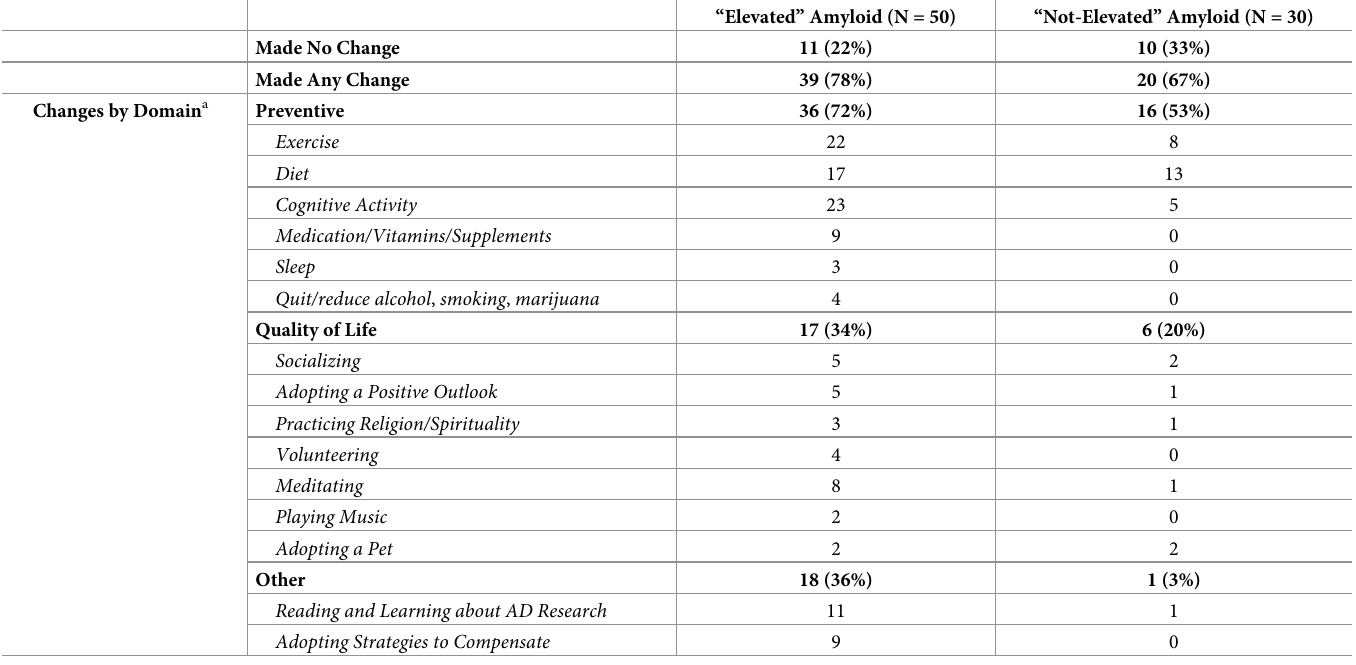
Table 3. Health behavior: Material derived from responses to the questions: “Have you made any changes in your daily life based on knowing your amyloid scan result?/ Have you started/stopped doing anything?/Are you spending time differently?” As well as queries about specific health behaviors: Diet, exercise, medica- tions/vitamins/supplements, stress reduction, mental/cognitive